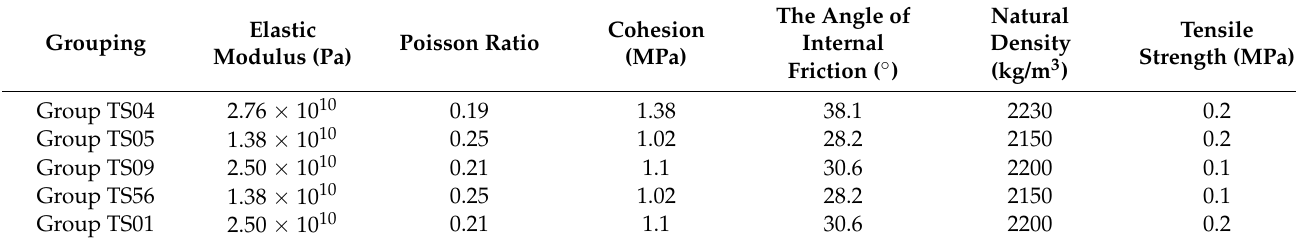
Table 1. Slate-related